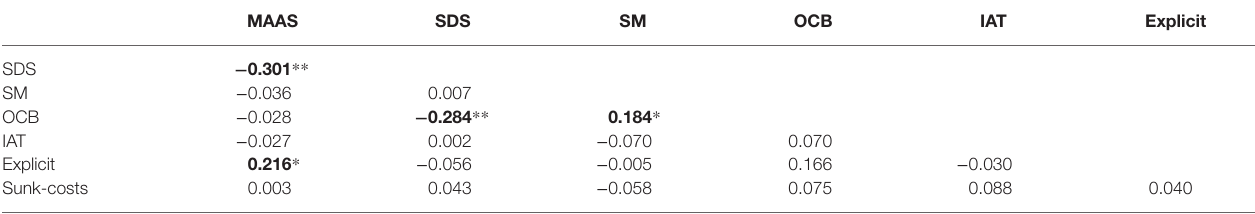
TABLE 4 | Associations between measures in Study